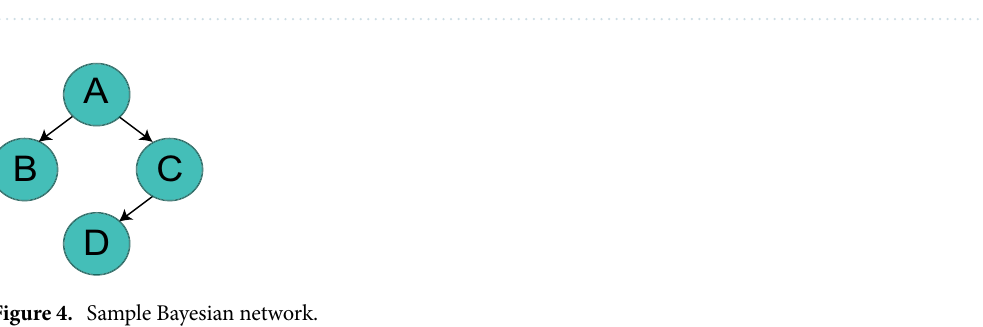
Figure 3. The heatmap plot of correlations between the subset of blood test parameters. The correlation between blood test parameters are used to exclude variables with redundant information from the modeling process.